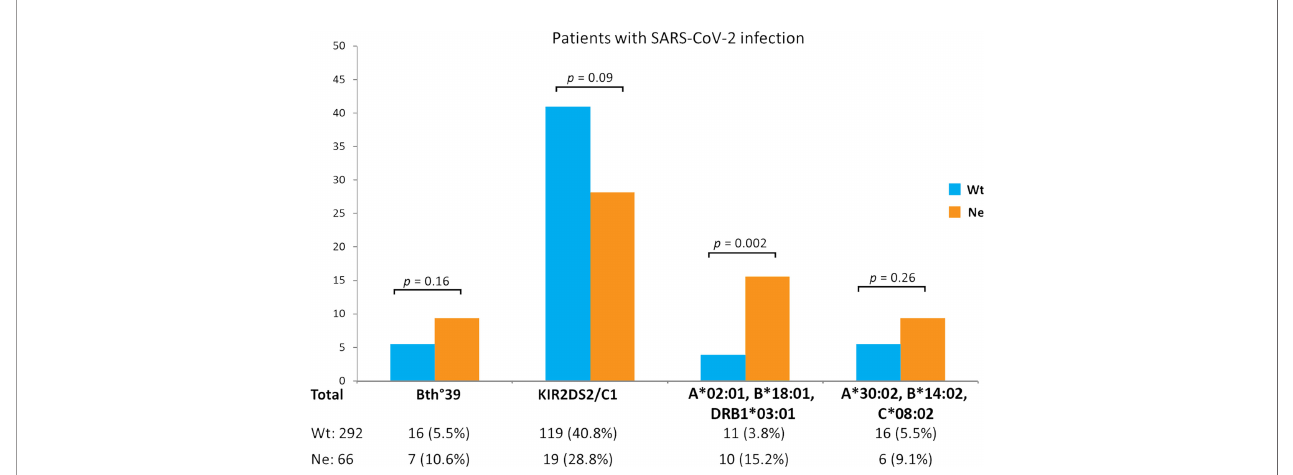
FIGURE 1 | Evaluation of differences in immunogenetic factors associated to SARS-CoV-2 infection in patients carrying either the Wild Type allele variant (homozygous for rs35044562/A = Wt) or Neanderthal allele variant (presence of rs35044562/G = Ne) of the leucine zipper transcription factor-like 1 ( LZTFL1 ) gene: